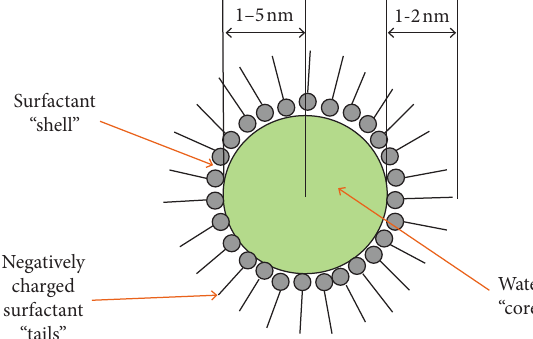
Figure 1: An emulsified water droplet (theoretical).